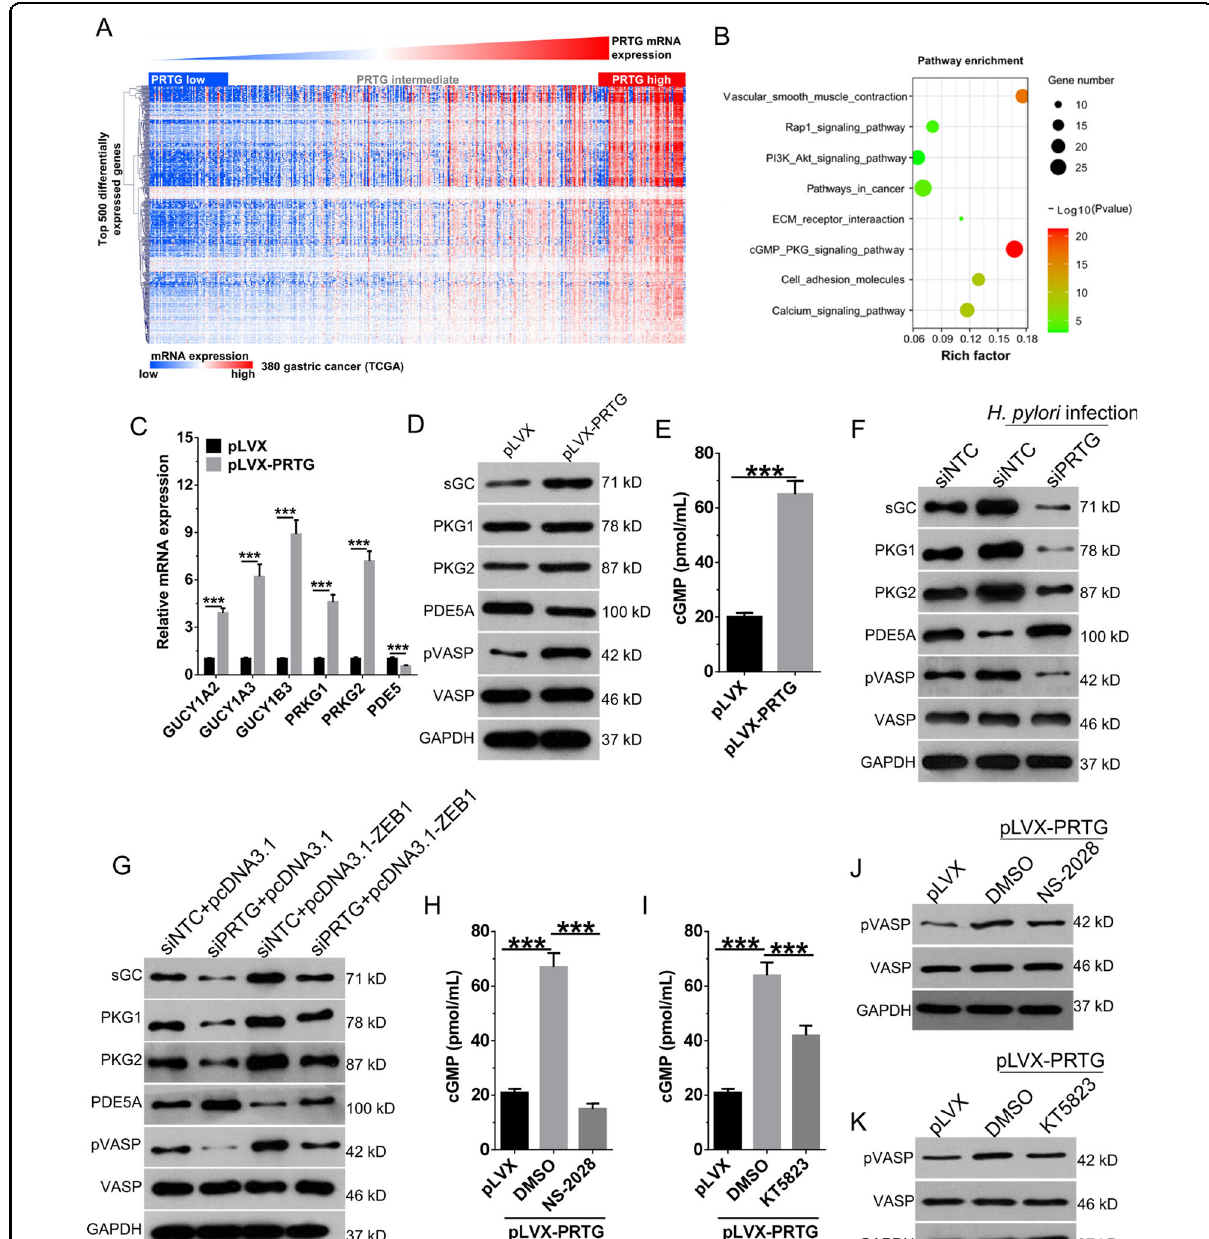
Fig. 5 PRTG activates the downstream cGMP/PKG signaling pathway in gastric cancer cells. A Expression of top 500 genes positively associated with PRTG expression in gastric patients from TCGA database. B Gene ontology term enrichment analysis for top 8 biological process controlled by differentially expressed genes in gastric patients. C and D The expression of cGMP/PKG signaling pathway related proteins in PRTG- overexpressing AGS cells were detected by qRT-PCR ( C ) and western blot ( D ). E Supernatant cGMP levels in PRTG overexpressing AGS cells were detected by ELISA. F PRTG silencing AGS cells were infected with H. pylori for 48 h, and then the expression of cGMP/PKG signaling pathway related proteins were detected by western blot. G AGS cells were transiently co-transfected with ZEB1 overexpressing plasmid and PRTG siRNA. 48 h later, the expression of cGMP/PKG signaling pathway related proteins were detected by western blot. H – K PRTG overexpressing AGS cells were treated with sGC inhibitor (NS-2028, 10 μ M) or PKG inhibitor (KT5823, 1 μ M) for 24 h. cGMP levels in supernatant and phosphorylated VASP expression were detected by ELISA and western blot, respectively. Data were presented as mean ± SD from the three independent replicates. *** P <